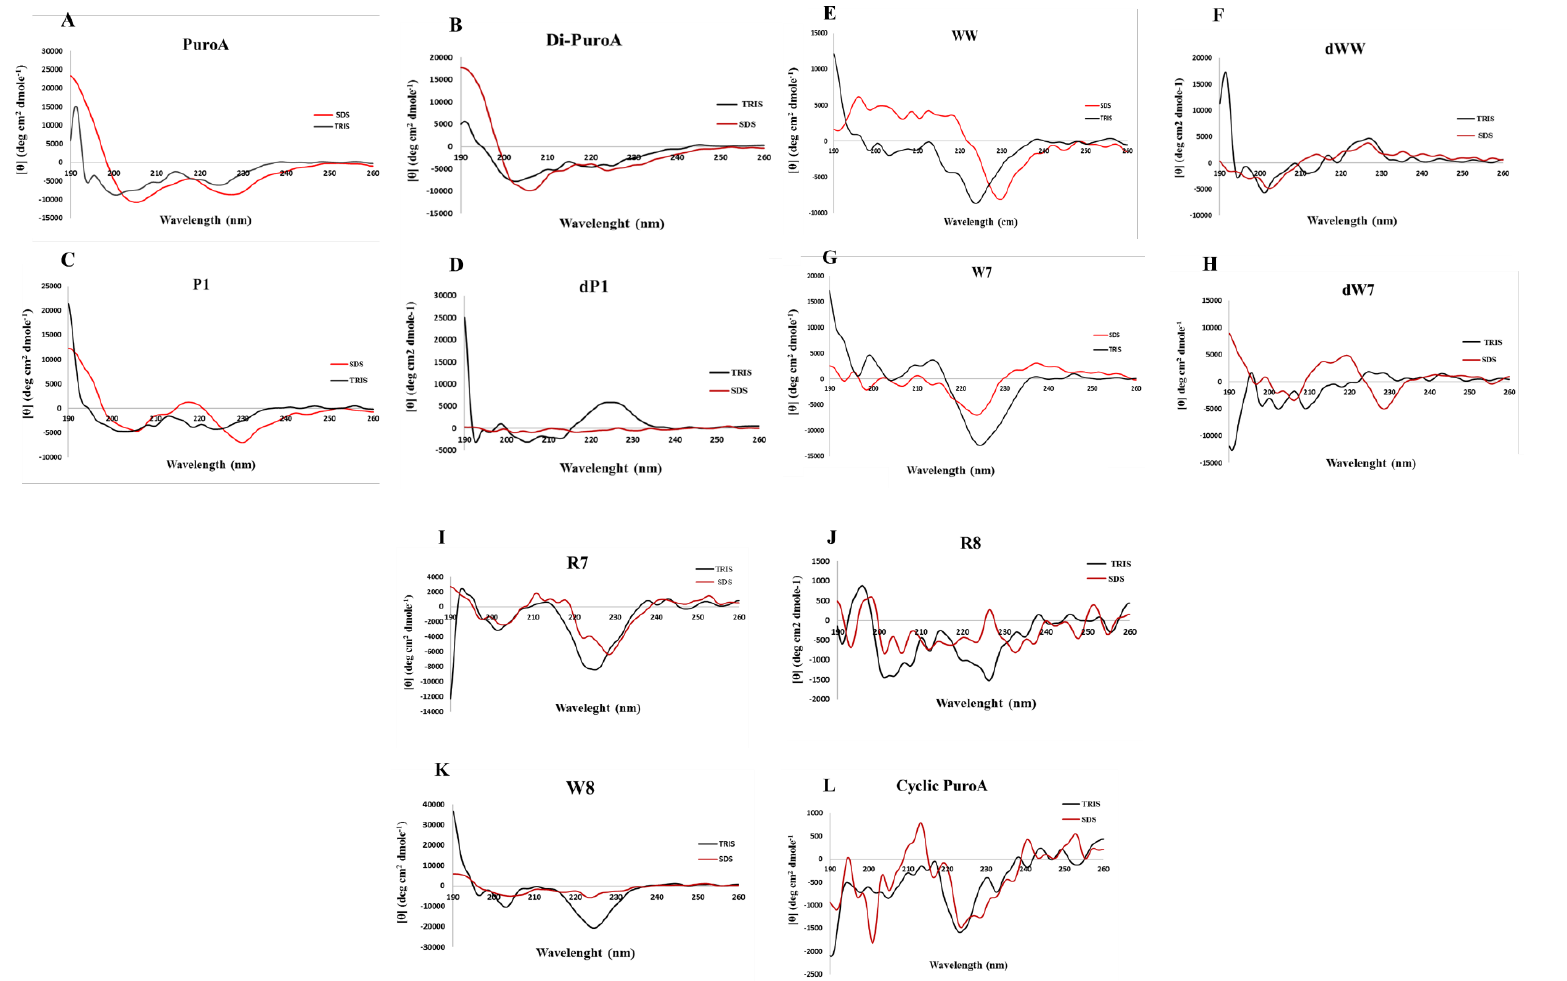
Figure 3. Circular dichroiism spectra of peptides. All spectra were recorded in 20 mM Tris buffer (black lines) or 20 mM SDS (red lines). θ = mean residue molar ellipticity.